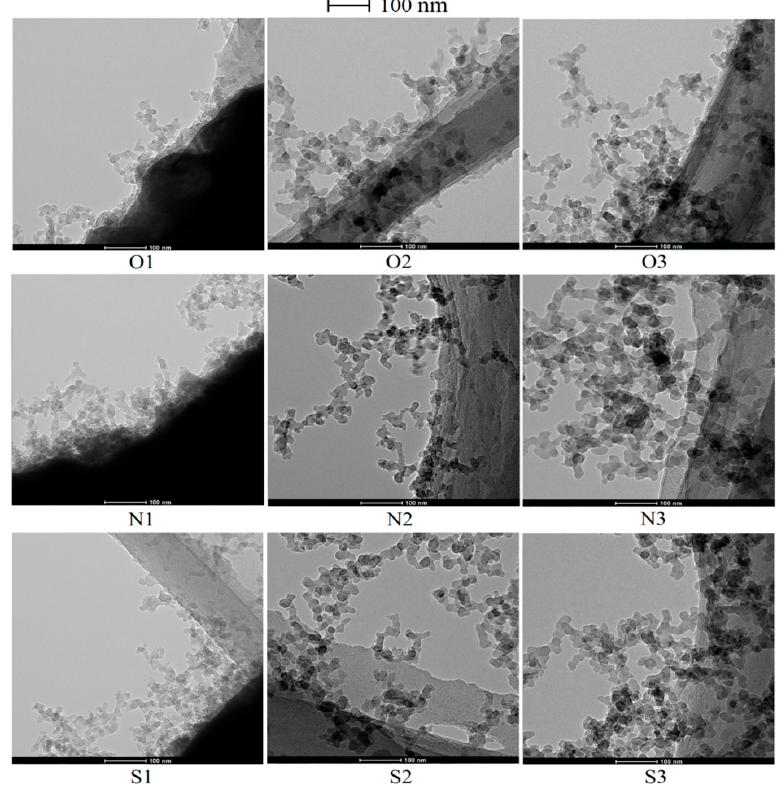
Figure 4. TEM images of soot particles sampled from cases listed in Table 1. (O1–O3 without effects of magnetic fields, N1–N3 with N pole of magnet facing the flame, S1–S3 with S pole of magnet facing the flame. O1, N1, S1 from pure n -heptane IDF, O2, N2, S2 from n -heptane IDF with 25% DMF-doped, O3, N3, S3 from n -heptane IDF with 50% DMF-doped).